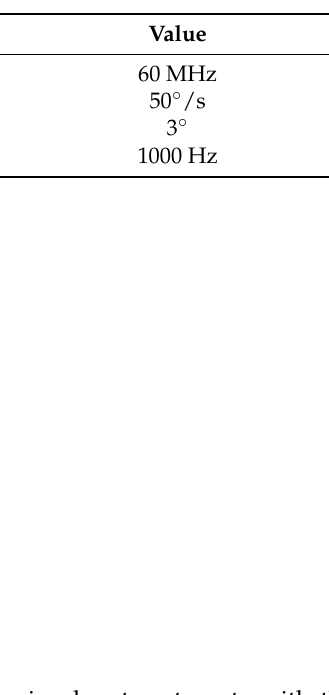
Table 1. Point simulation parameters.